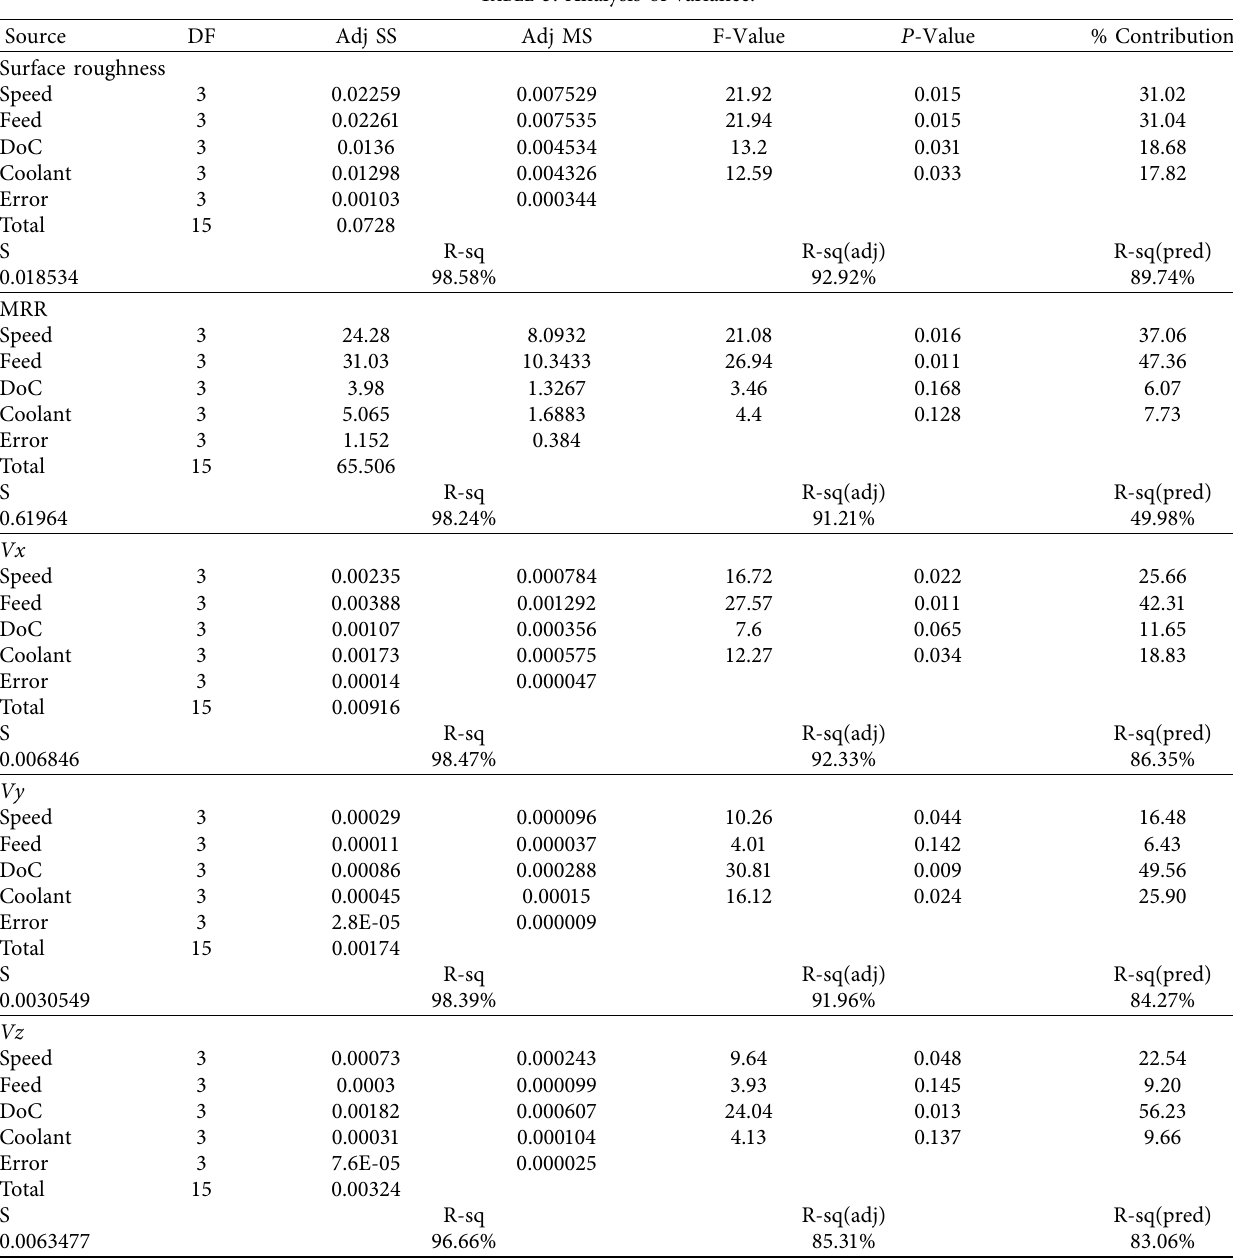
Table 5: Analysis of